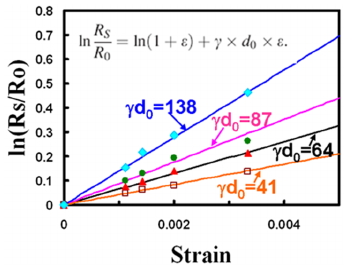
Figure 8. Plots of ln( R S / R 0 ) dependence on the applied ε for 0, 1, 2, and 3 HR paths of the flexible PR strain sensors. The solid lines represent a fitting line to our experimental results with two parameters of γ and the initial tunneling distance (d 0 ) in Equation (6). The γꞏ d 0 of 41, 64, 87, and 138 can be found for 0, 1, 2, and 3 HR paths, respectively.